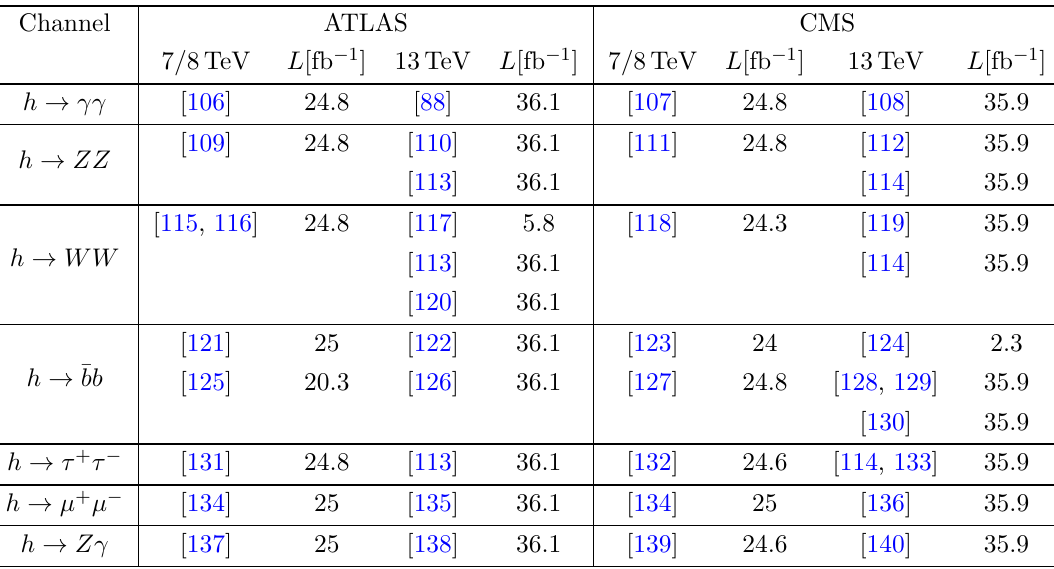
Table 1 . Higgs boson signal strengths included in our (cid:12)ts to the electroweak chiral Lagrangian, classi(cid:12)ed according to the (cid:12)nal states and indicating the integrated luminosity, L , of the correspond- ing data sets. Multiple entries in a single cell refer to di(cid:11)erent production modes. We summarize 7 and 8 TeV data for brevity. We also include CDF [141] and D (cid:1) 0 [142] data sets in our (cid:12)t.